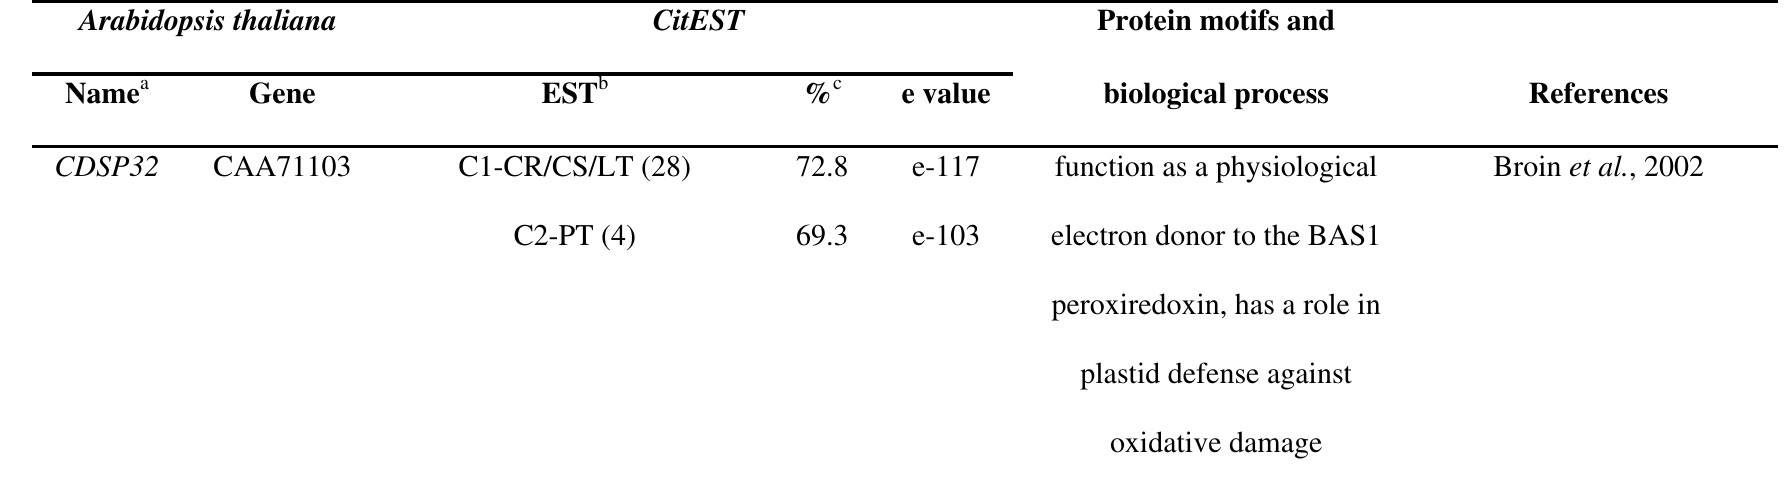
Table S12 – Citrus ESTs with homology to thioredoxin protein from Solanum tuberosum